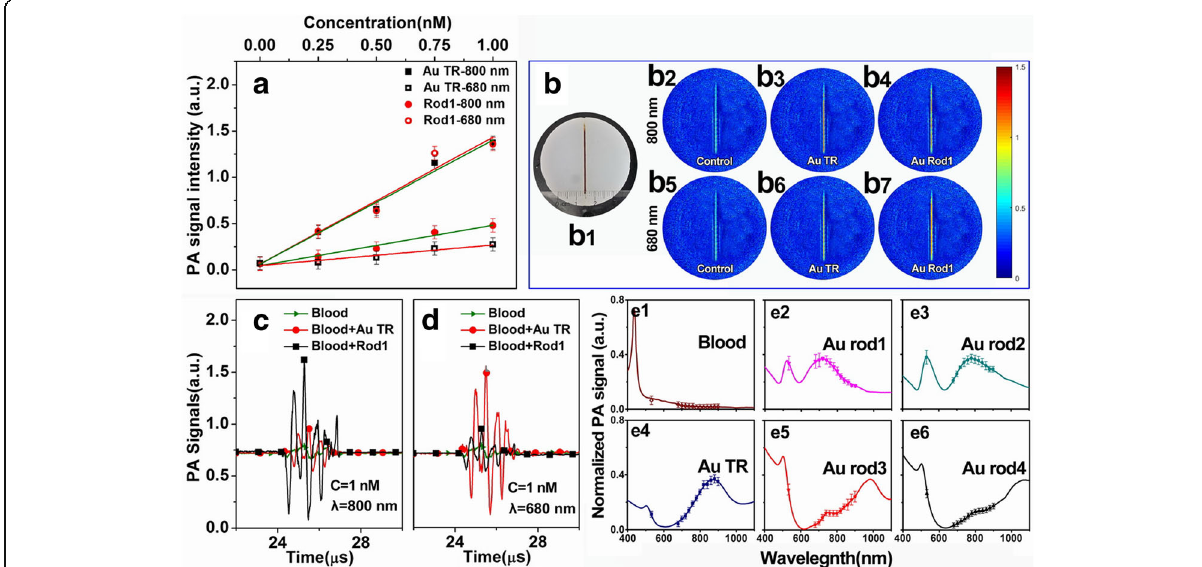
Fig. 3 In vitro photoacoustic properties of AuTR and AuNRs: a concentration-dependent photoacoustic signal intensity of AuTR and Au rod1 irradiated by 800- and 680-nm laser, respectively, b PAI of glass capillary fulfill with blood balance mixed with 1 nM AuTR or Au rod1 irradiated by 800- and 680-nm laser, c , d the comparison of photoacoustic signal amplitude between pure blood and blood balance mixed with 1 nM AuTR or Au rod1 irradiated by 800- and 680-nm laser, e1 – e6 comparison of absorption spectra (solid line) of five kinds of synthesized AuNRs and fresh ox blood obtained from multi-wavelength photoacoustic signals amplitude (data points)